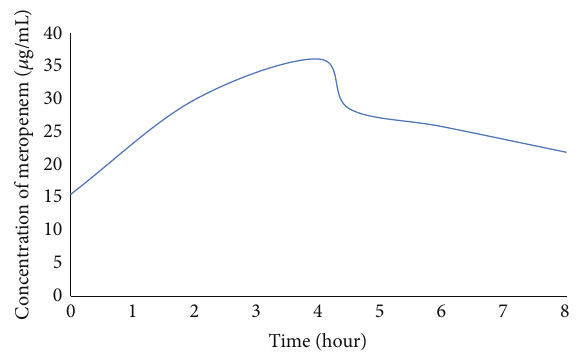
Figure 1: Typical serum concentration-time profile of meropenem given as a 4h prolonged infusion of 40 mg/kg, every 8